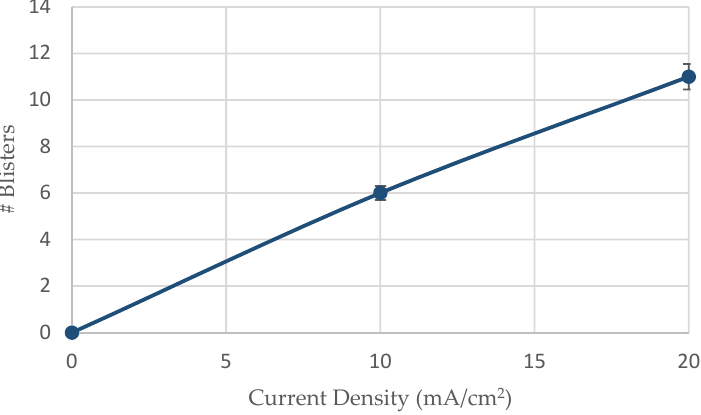
Figure 13. Surficial density of blister formations related to the applied current density during the in situ hydrogen cathodic charging process and slow strain rate bending loading.